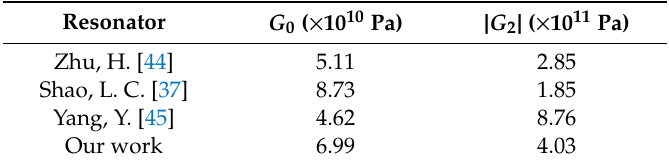
Table 3. Comparison of the extracted nonlinear shear modulus G 0 and G